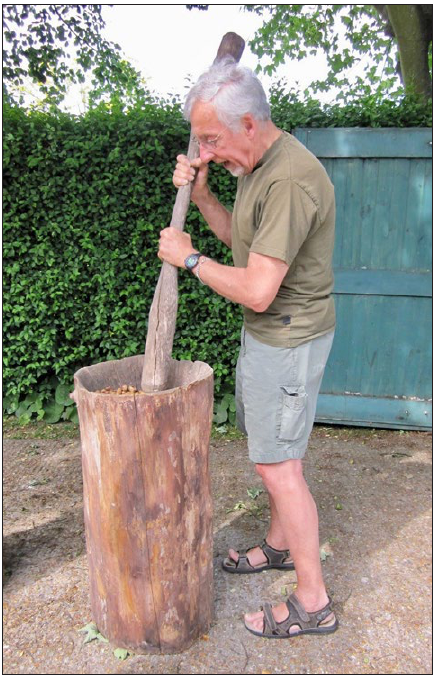
Figure 4: Gordon Hillman pounding acorns (Photo: Dorian Q